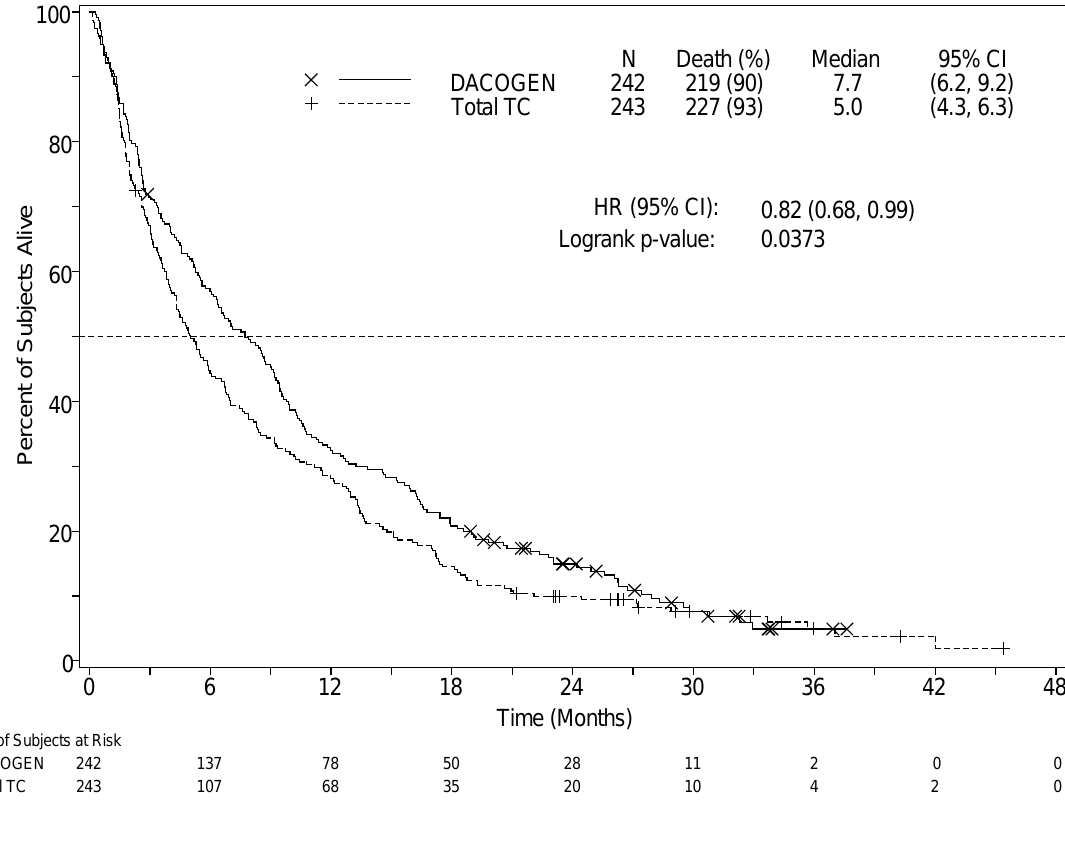
Figure 4: Analysis of mature overall survival data (Study DACO-016: Intent-to-Treat